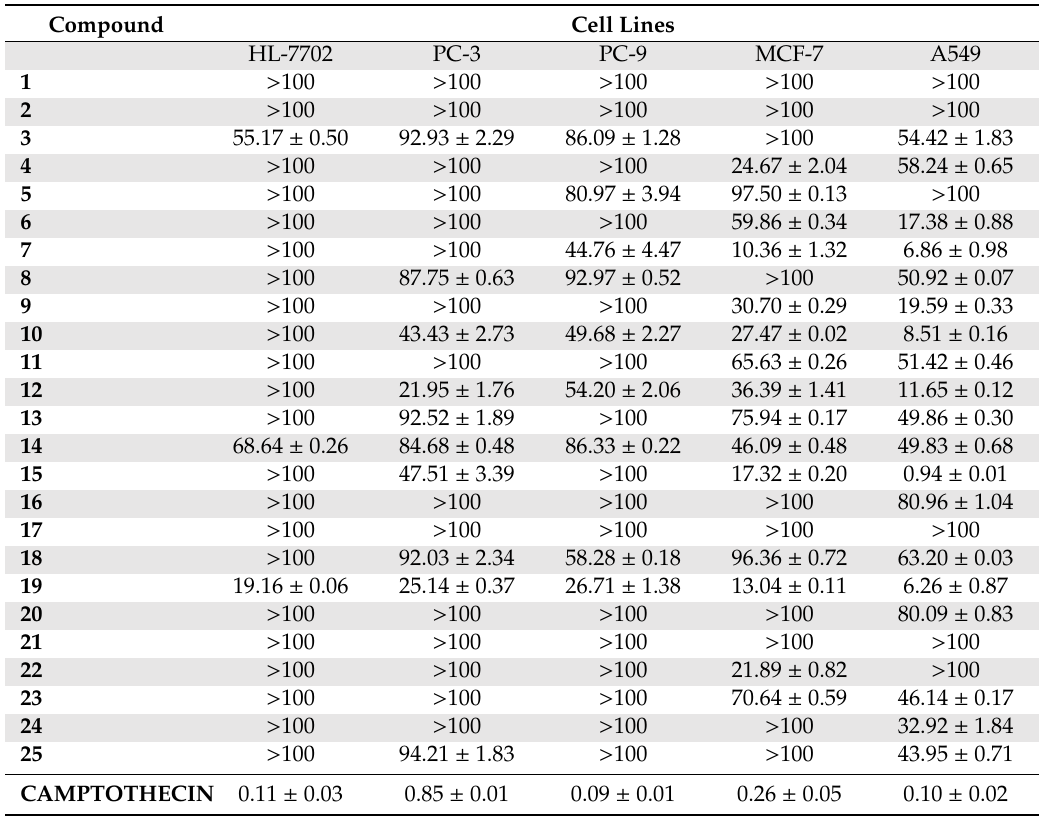
Table 1. Cytotoxic activity * (IC 50 , µ M) of compounds 1 – 25